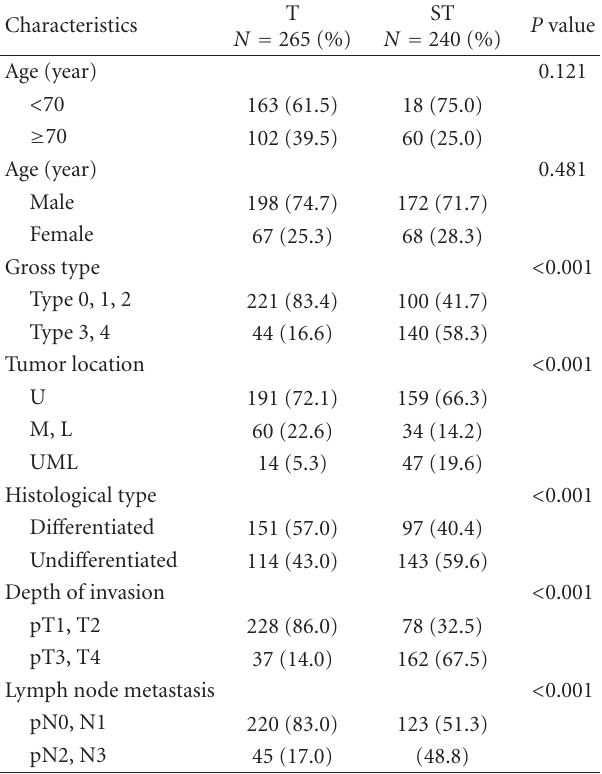
Table 1: Clinicopathological characteristics of the patients who underwent total gastrectomy with or without splenectomy ( N = 505).